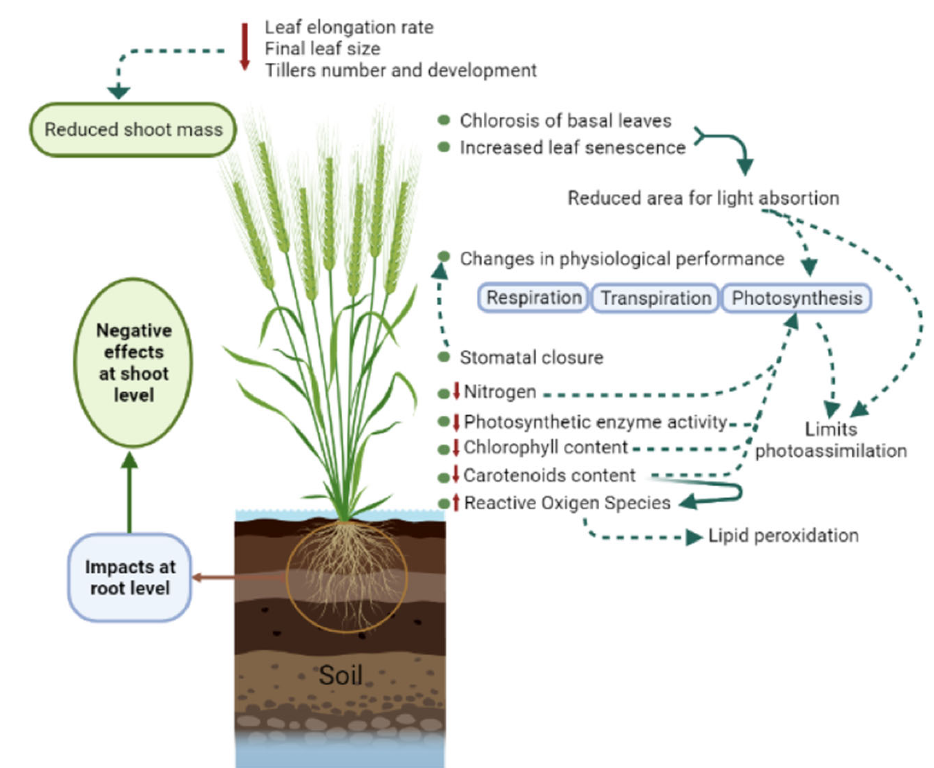
Figure 2. Effects of waterlogging at shoot level. Figure elements created using biorender.com (accessed on 15 December 2022).